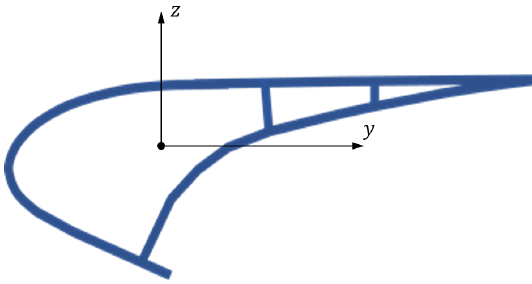
Figure 2. Cross-section of the